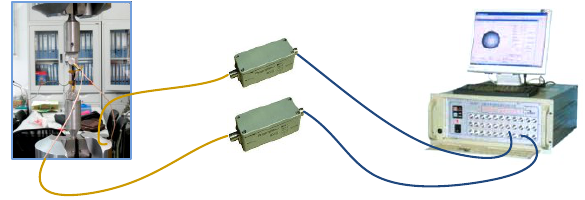
Figure 2. The system of tensile test with acoustic emission instrument.